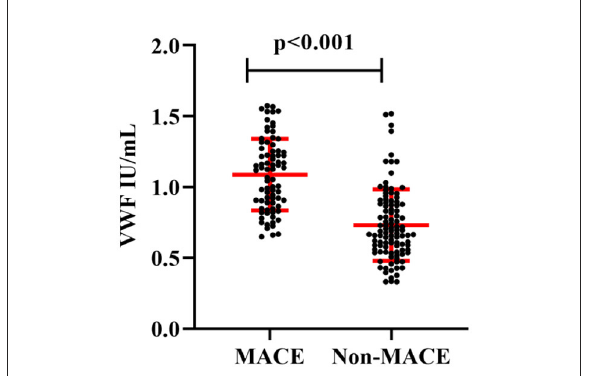
FIGURE2 Comparison of plasma VWF: Ag levels ( x ± s ) between the MACE and non-MACE groups. fold increased risk of MACEs was noted (HR = 6.004 95%CI: